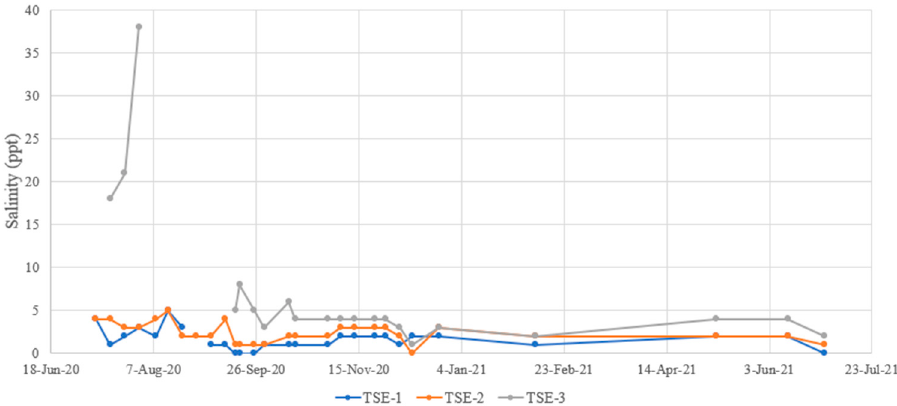
Figure 8. Collected salinity level readings of treated sewage effluent ponds (TSE) -1, -2, and -3. The